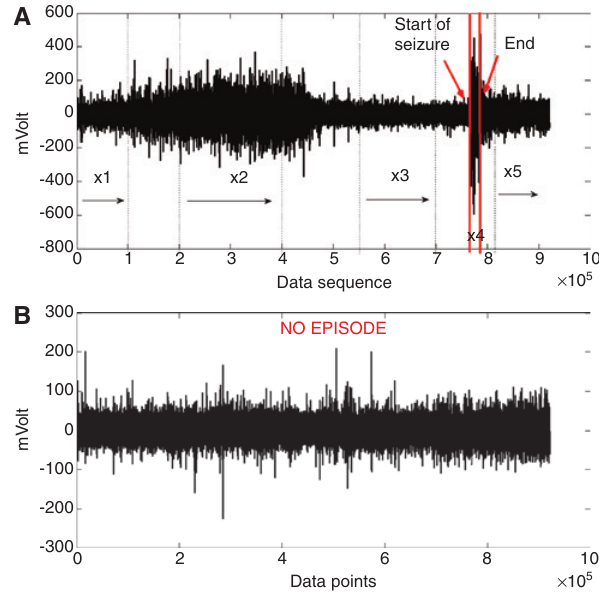
Figure 1: Tsallis q-triplet of two EEG time series concerning epileptic and healthy states. (A) EEG time series including an epileptic episode. The initiation of the episode and its end is denoted by the red vertical lines. (B) EEG time series of the same patient with no